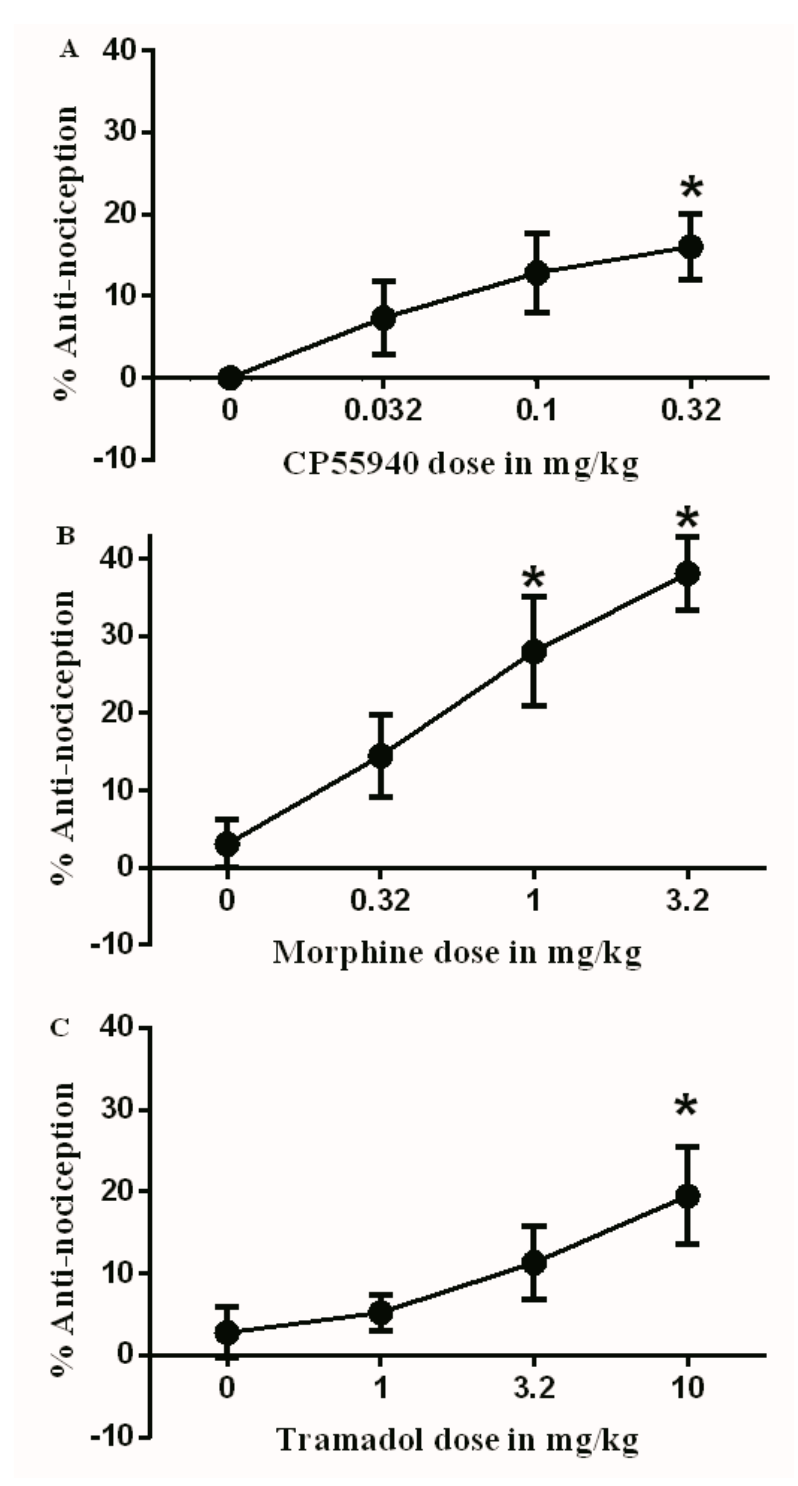
Figure 1. Antinociceptive e ff ects of ( A ) CP55940 (0.032, 0.1, and 0.32 mg / kg); ( B ) morphine (0.32, 1, and 3.2 mg / kg); and ( C ) tramadol (1, 3.2, and 10 mg / kg) on complete Freund’s adjuvant (CFA)-induced mechanical allodynia. Data are presented as the mean ± SEM of %antinociception. %antinociception = (paw withdrawal thresholds (PWT) Post-drug – PWT Pre-drug) / (baseline PWT – PWT pre-drug). Data were analyzed using the one way ANOVA test followed by Dunnett’s post hoc test (* p < 0.05, n = 6 rats per group).